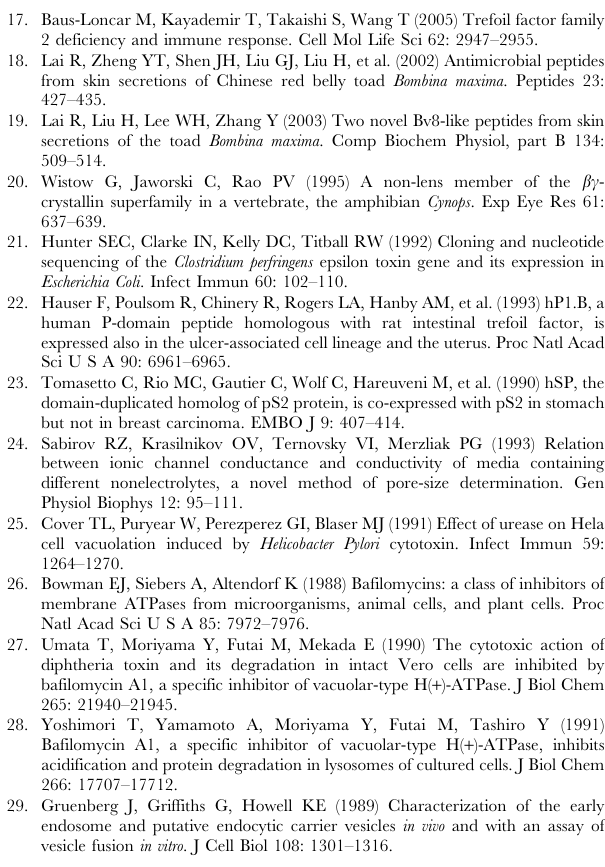
genes (fold change $ 3, q value= 0, FDR (false discovery rate) = 0) are shown (columns show treated cells organized anatomically and rows present genes organized by hierarchical clustering). A color tag represents expression levels, with red representing the highest levels and green representing the lowest levels of expression. Figure S2 Distribution of betagamma-CAT and/or the homo- logues of its each subunit in frog B. maxima skin, intestine and stomach. Frog tissue cryostat sections were prepared as described in supporting information. Serial sections were stained with rabbit polyclonal antibodies against betagamma-CAT alpha-subunit (D1–F2), beta-subunit (G1–I2), respectively (green channel). Pre- immunized rabbit IgG (A1–C2) was used as control. Nucleus was counter-stained with PI (red channel). The same cryostat sections were observed by phase contrast in order to demonstrate morphology (A1, B1 and C1; D1, E1 and F1; G1, H1 and I1). Scale bars equal to 100 m m. In A2, D2 and G2, S, serous glands; L, lipid glands; M, mucous glands; D, dermis; E, epidermis. Found at: doi:10.1371/journal.pone.0001770.s003 (6.41 MB TIF) Table S1 All significantly differential expression of 123 genes of HUVECs induced by betagamma-CAT, as listed in Excel file. Found at: doi:10.1371/journal.pone.0001770.s004 (0.03 MB